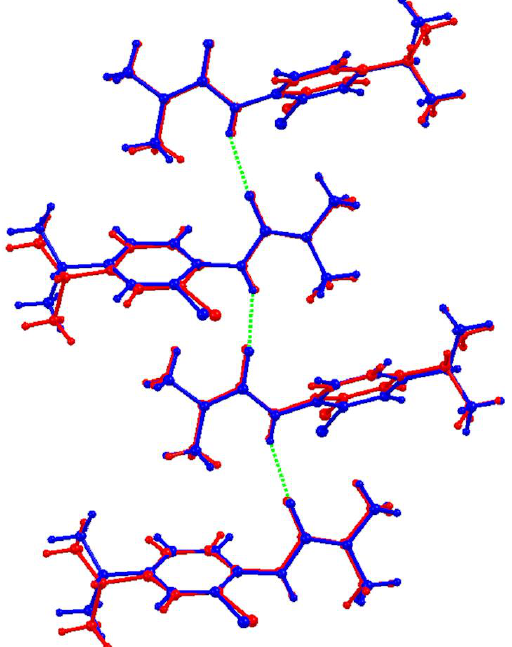
Figure 4. An overlay of the hydrogen bonded chains from 1 LT (red) and 2 (blue). The minor disorder component in 1 has been omitted for clarity. component in 1 has been omitted for